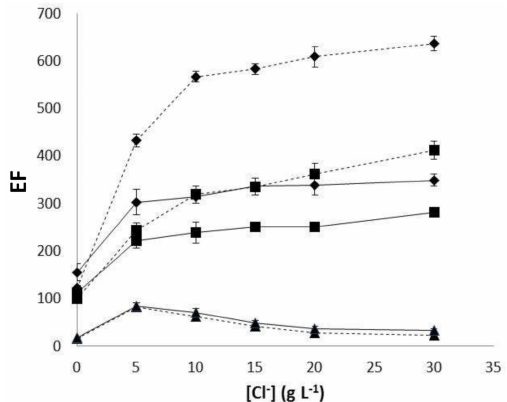
Figure 4. Variation of EF against Cl − concentration in samples for the three evaluated hollow fiber types: (cid:7) Accurel PP 50 / 280, (cid:4) Accurel PP Q3 / 2, and (cid:78) Accurel PP S6 / 2. Time of extraction 120 min. Dotted line represents 20 µ L acceptor solution and Solid line represents 40 µ L acceptor